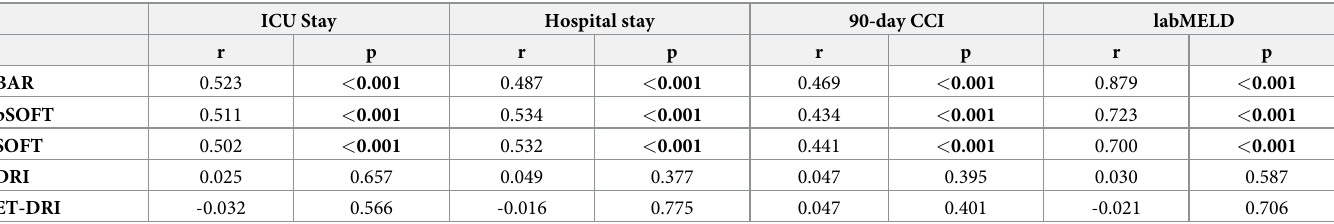
Table 7. Association between the BAR, pSOFT, SOFT, DRI and ET-DRI scores and perioperative outcome parameters as well as pre-transplant